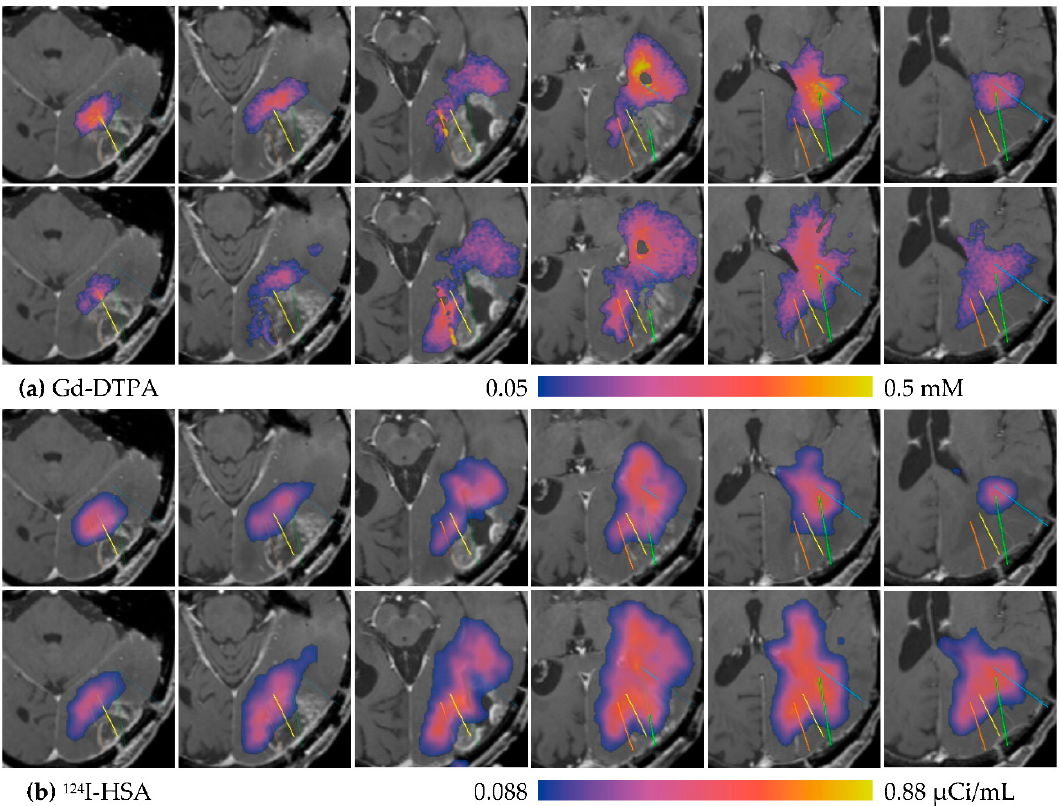
Figure 5. MR1-1 Patient 7 measured distribution (in color, overlaid on pre-infusion T1-weighted MRI, six axial slices, 10 mm apart). Colored lines indicate the approximate catheter placements, which are not entirely in-plane. The opaque portion of the line is inferior to the slice and the translucent portion is superior. ( a ) Measured Gd-DTPA concentration: (Top) after 24 h of infusion; and (Bottom) after 72 h of infusion. ( b ) Measured 124I-HSA concentration: (Top) after 24 h of infusion; and (Bottom) after 72 h of infusion.